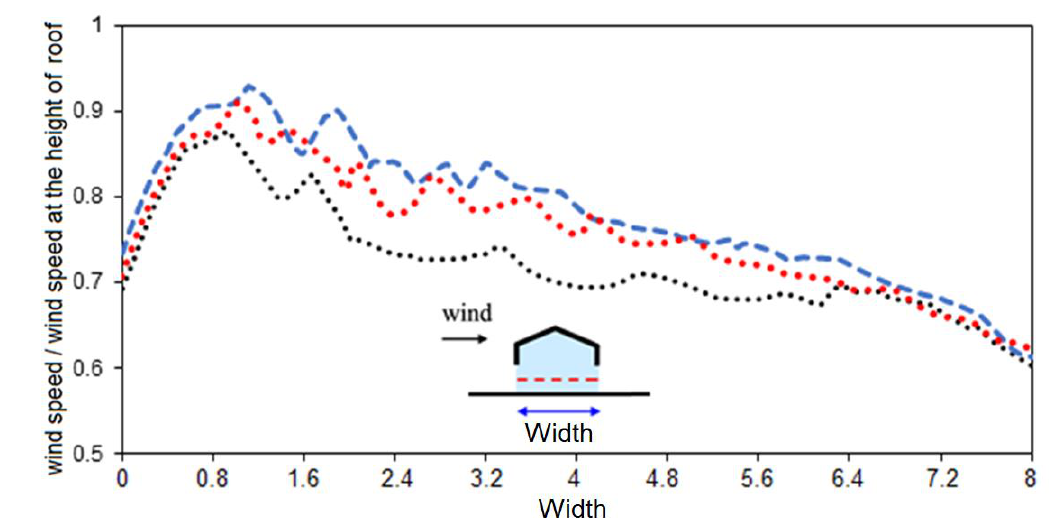
Figure 7. Simulated results of air velocity along a horizontal centre line of the empty greenhouse model (no crops) at a height of 0.8 m for the grid sensitivity analysis . (no crops) at a height of 0.8 m for the grid sensitivity